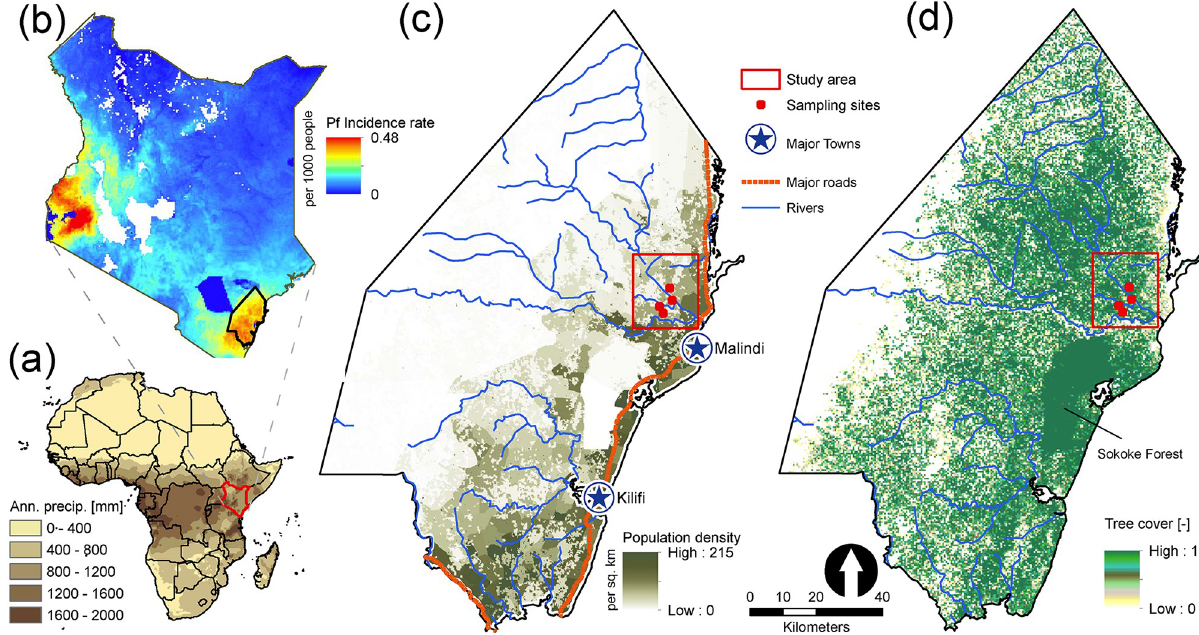
Fig 2. Map of study area in Kilifi county, Kenya. (a) Mean annual precipitation gradient map of Africa showing Kenya in red region. (b) Distribution of P. falciparum incidence rate in Kenya. Areas that have no data are shown in white. The Kilifi county (bottom right, black polygon) is one of the regions of highest malaria incidence in Kenya. Data is obtained from the Malaria Atlas Project [54]. (c) Map of population density distribution in Kilifi county, Kenya (Data is adapted from [56]). Simulations are conducted for the area of 440 km 2 indicated by the red rectangle. (d) Map of tree cover in Kilifi, Kenya. Data is obtained from the World Resource Institute (http://www.wri.org).